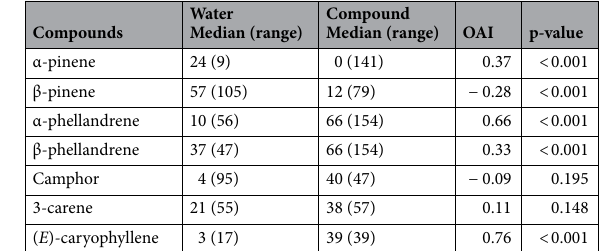
Water Median (range)